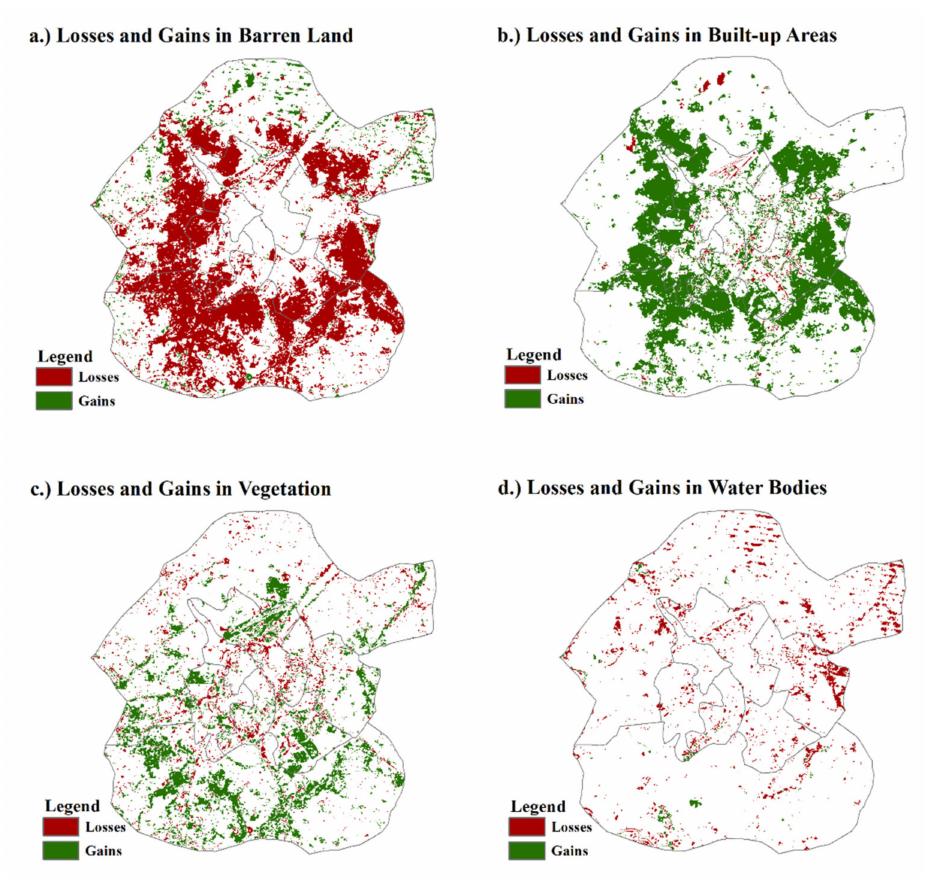
Figure 6. Losses and Gains in LULC classes from 1991–2020.